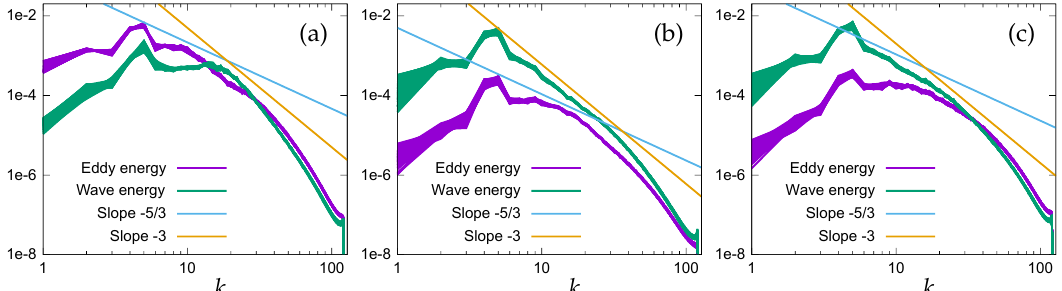
Figure 13. Energy spectra against wavenumber k for the wave (in green) and eddy (in magenta) parts. k − 5/3 and k − 3 scalings are also indicated for reference. ( a ) Horizontal kinetic energy split in wave E (cid:63) , w and eddy E (cid:63) , e parts. ( b ) Vertical kinetic energy for wave E (cid:63) , w z and eddy E (cid:63) , e z contributions. h h ( c ) Potential energy in the wave E (cid:63) , w and eddy E (cid:63) , e parts. Several curves are presented for each b b spectrum, corresponding to 200 times in the interval t ∈ [ 70;80 ]